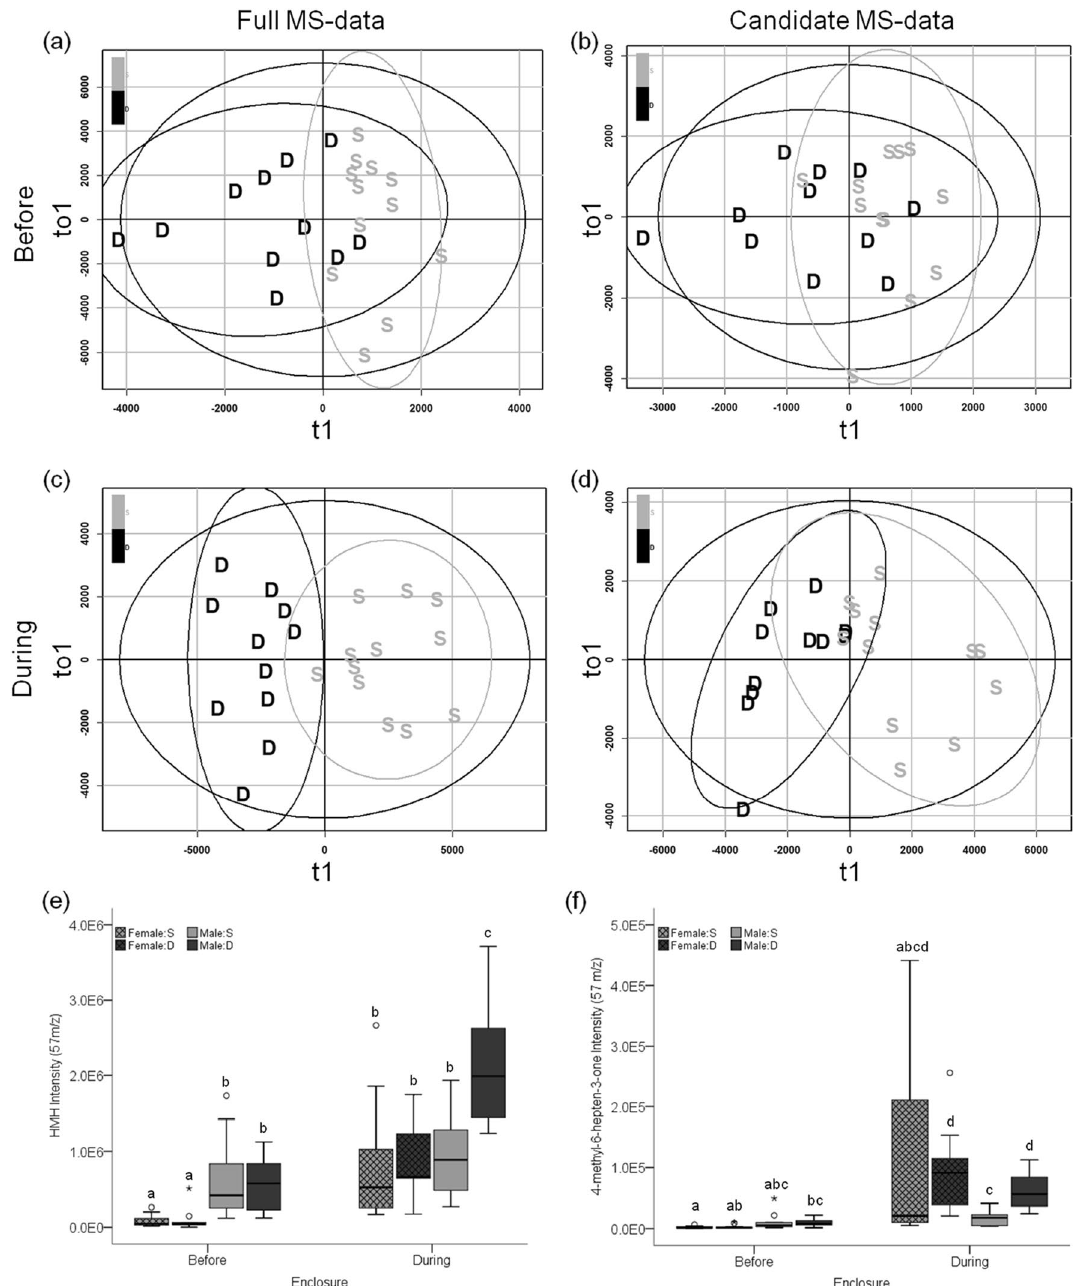
Figure 5. VOC expression in relation to social status. OPLS-DA scores plots of social status before ( a , b ) and during the enclosures ( c , d ) based on the full MS-data ( a , c ) and the candidate MS-data ( b , d ) derived from denatured male urine (n = 23).The x-axis of the scores plot is the predictive component (t1) and the y-axis is the first orthogonal component (to1). Data points for dominant (black) and subordinates (light gray) are labelled D and S, respectively. The boxplots show differential expression of HMH and 4-methyl-6-hepten-3-one ( e and f , respectively) in intact urine for dominant (D) and subordinate (S; dark and light gray, respectively) males and females (lattice; n = 24) at both enclosure phases. Different letters above the boxplots denote significant